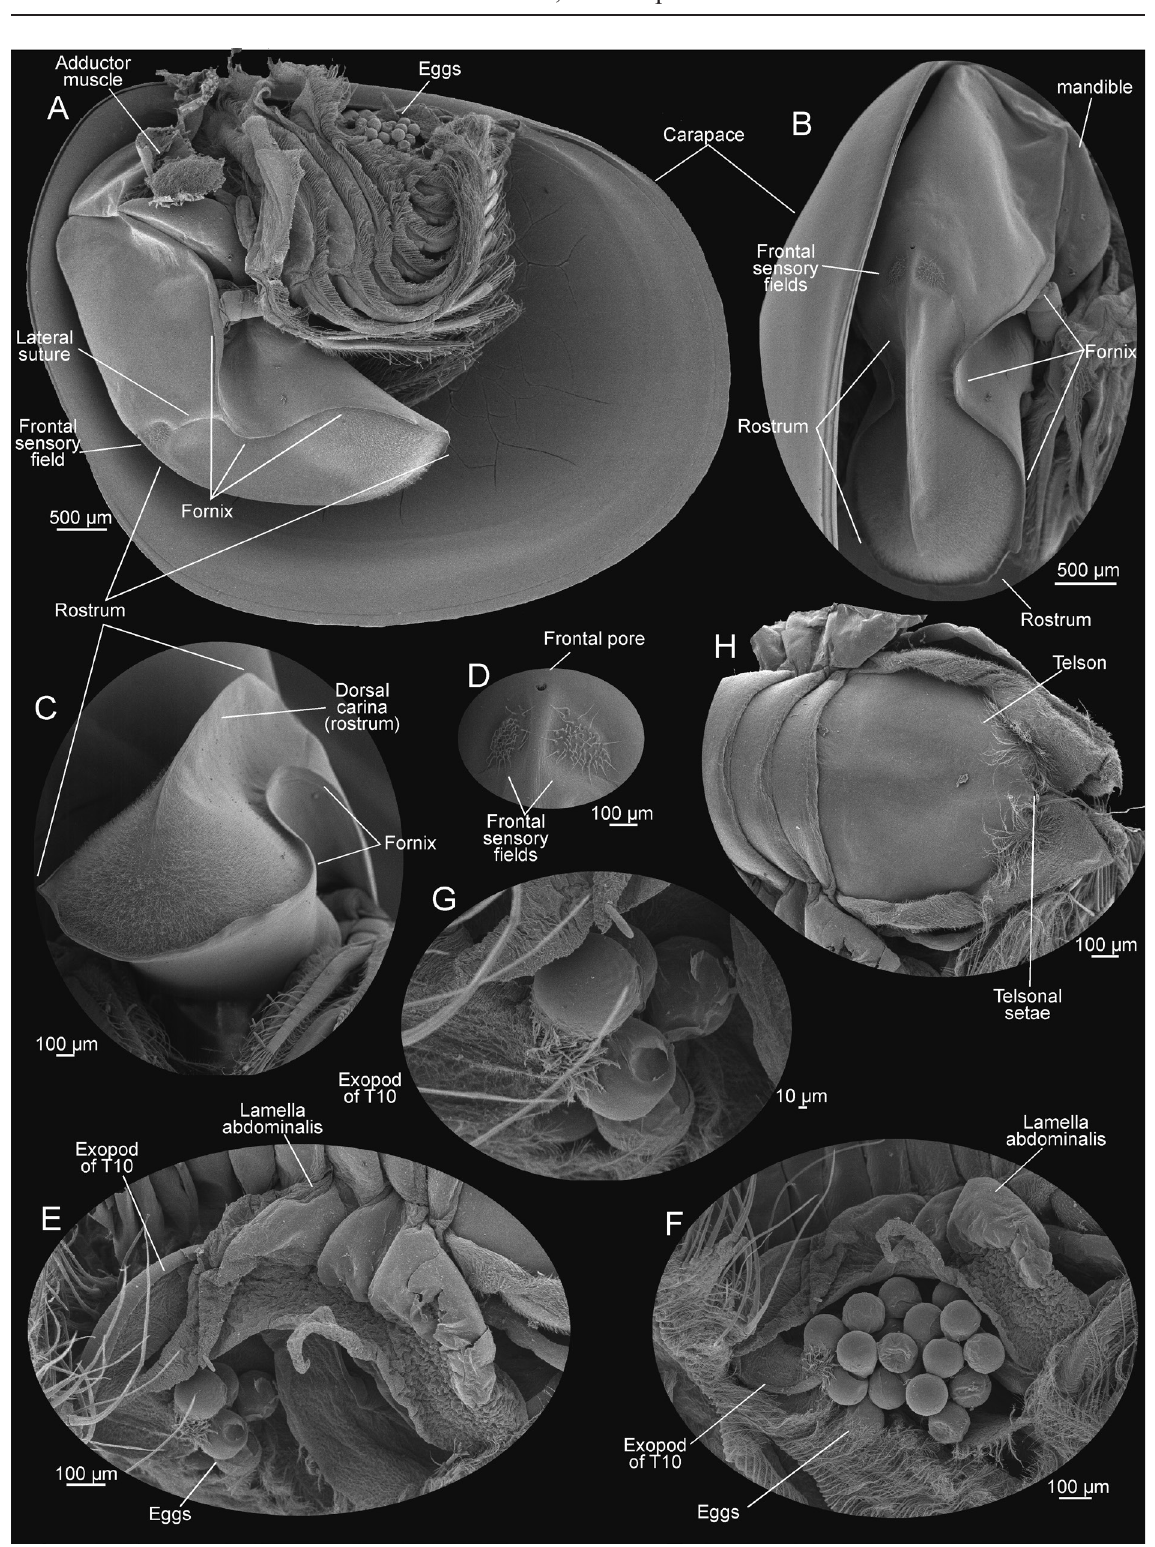
Fig. 4. Lynceus insularis sp. nov., ♀, scanning electron microscopy (ZMUC-CRU-4787). A. Left lateral view with carapace valve removed. B . Head/rostrum, anterior view. C . Rostrum, anterior view. D . Frontal sensory fields and pore leading to compound eyes. E–F . Lamella abdominalis and eggs of left side. G . Attachment of thoracopod 10 exopod to